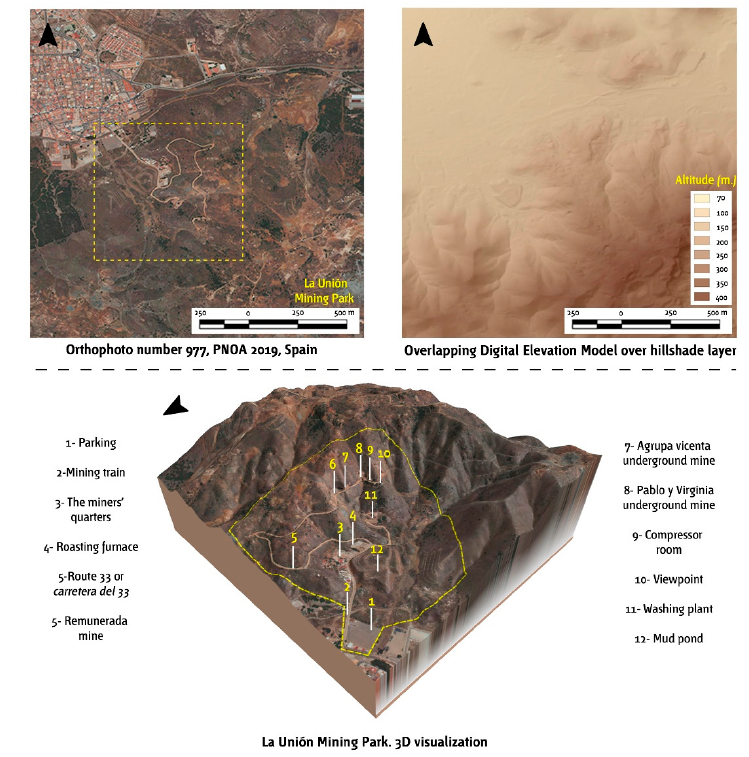
Figure 3. Digital representations of La Unión Mining Park. Source: own statistics.